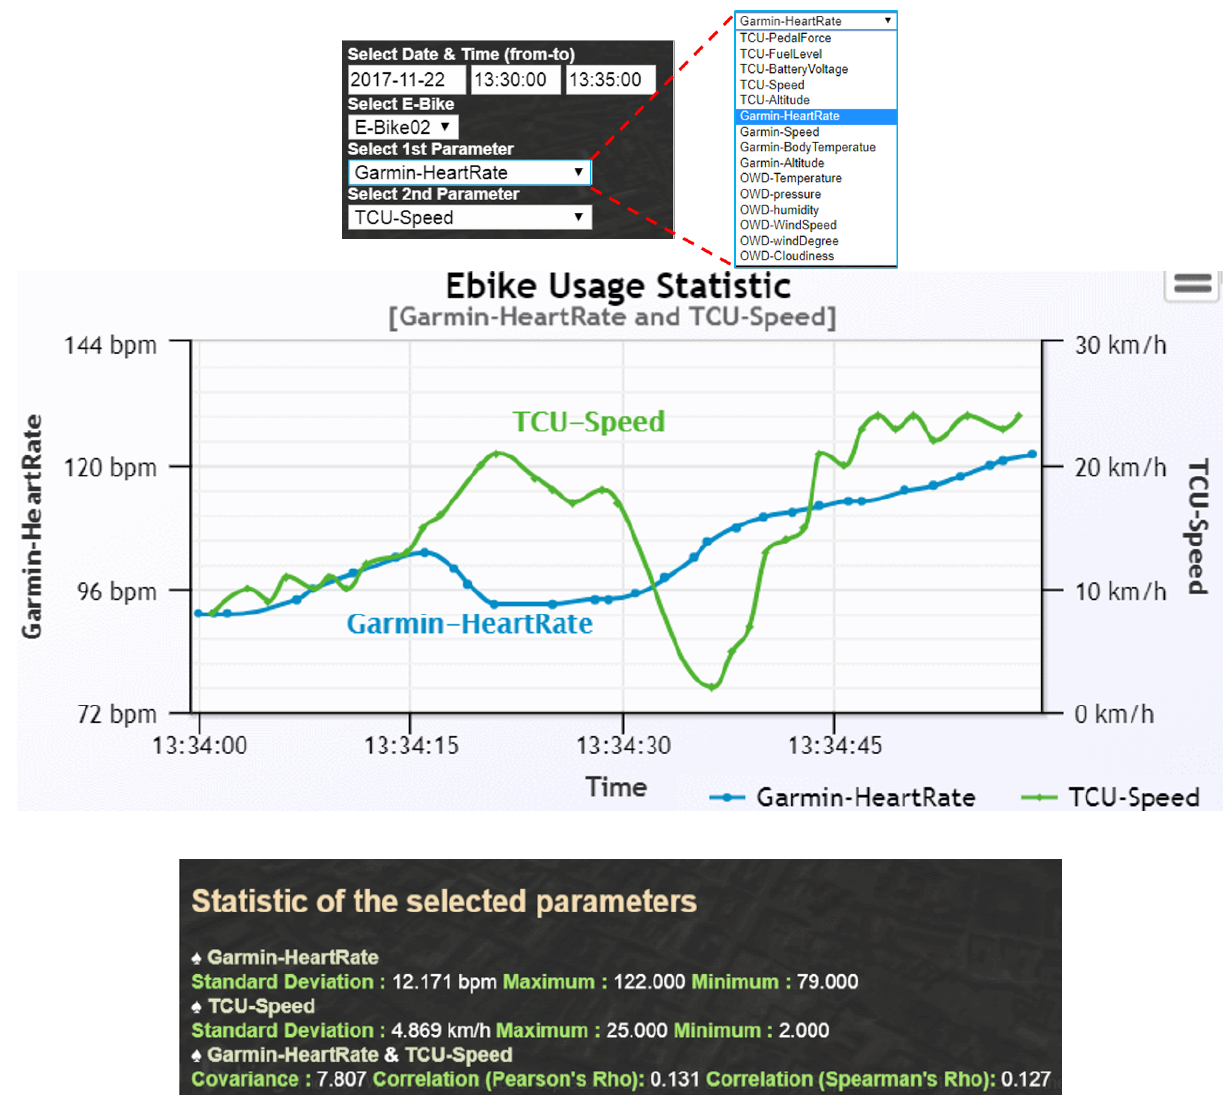
Figure 6: Participant statistics : Garmin-HeartRate v/s